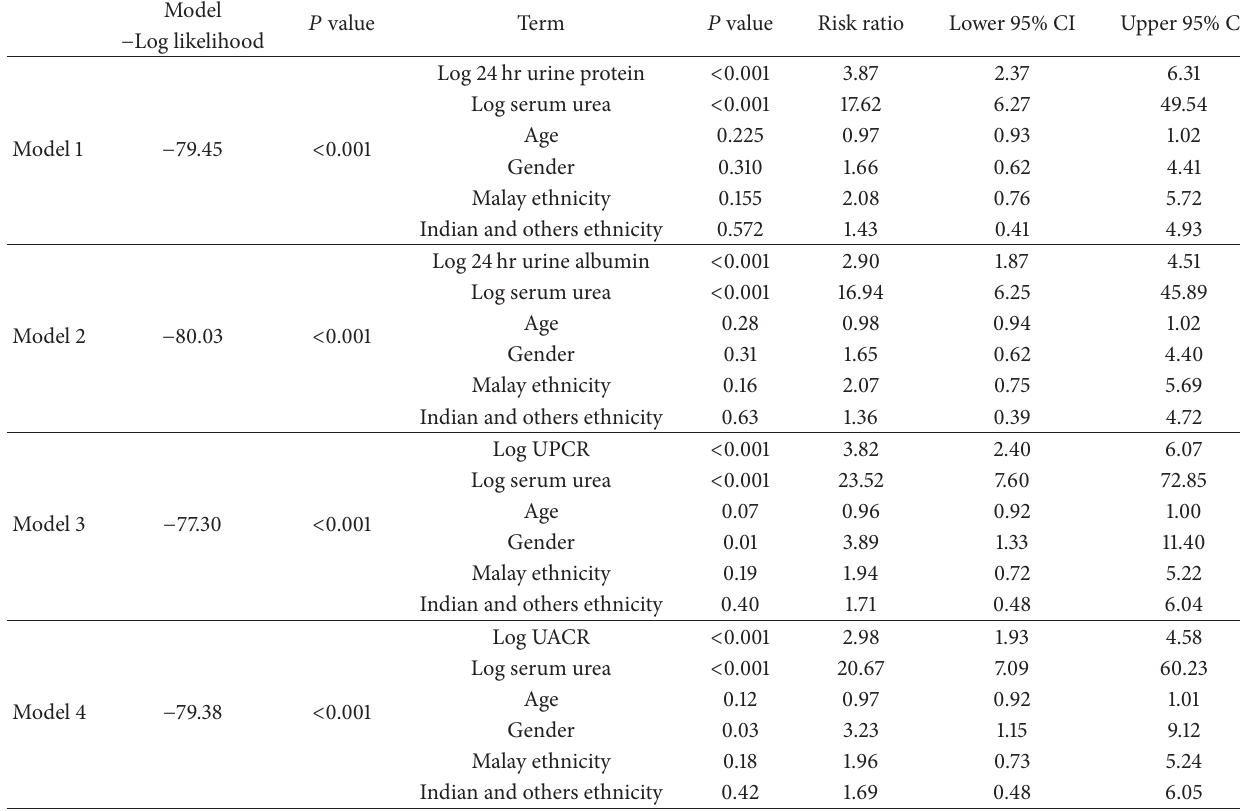
Table 4: Proportional hazards models predicting the combined end-point of ESRD and